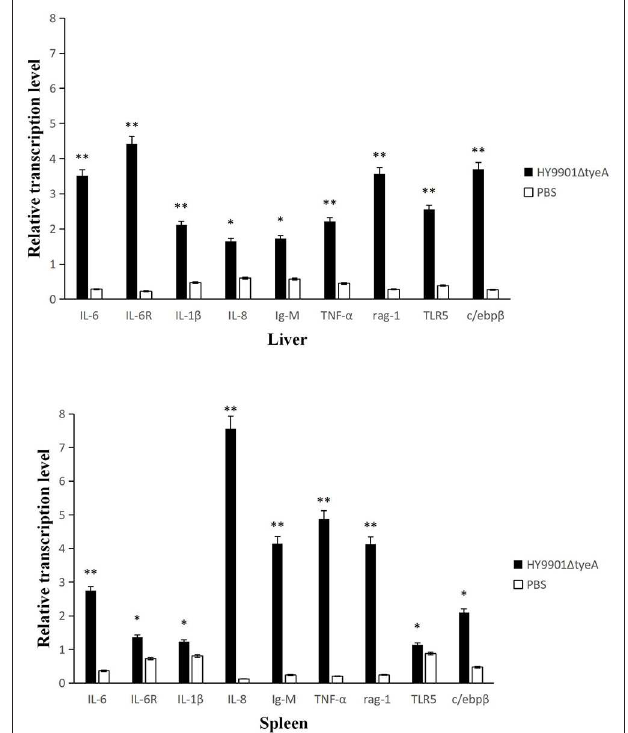
FIGURE 10 | Comparative analysis of the expression of immune-related genes in liver and spleen of zebrafish given the live attenuated vaccine and unvaccinated zebrafish. The head kidney and spleen of grouper were sampled at 1 day before challenge, and the mRNA level of each immune-related gene was normalized to that of β -actin. Bars represent the mean relative expression of three biological replicates and error bars represent standard deviation. its regulation mechanism in V. alginolyticu s remains